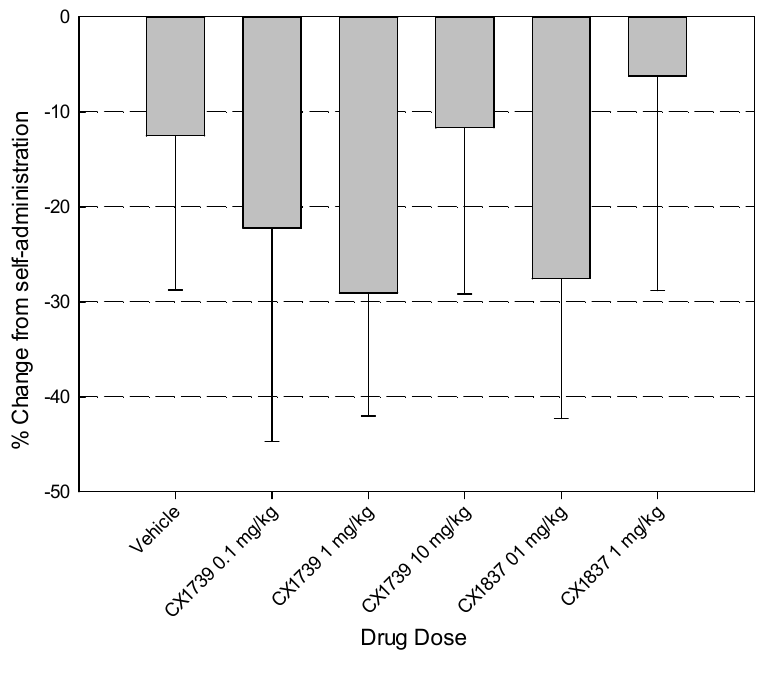
Figure 2. Following extinction sessions, rats were placed into cue-primed reinstatement procedures to assess the retention of extinction learning. Data points represent the mean percent change (±SEM) from self-administration (mean of the final 2 days of self-administration procedures) for active lever presses. A one-way ANOVA did not reveal significant differences between vehicle or any CX1837 doses (0.1 or 1 mg/kg, i.p.), F(3,39) = 0.161, p = 0.922, nor any significant differences between vehicle and of the doses of CX1739 tested (0.1, 1, or 10 mg/kg, i.p.), F(2,35) = 0.294, p =